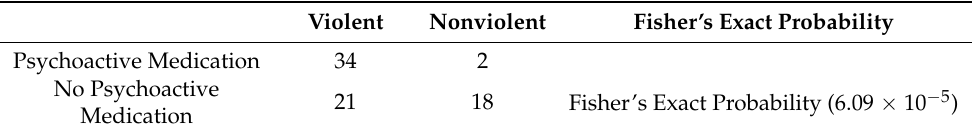
Table 5. Fisher’s exact probability test of the use of psychoactive